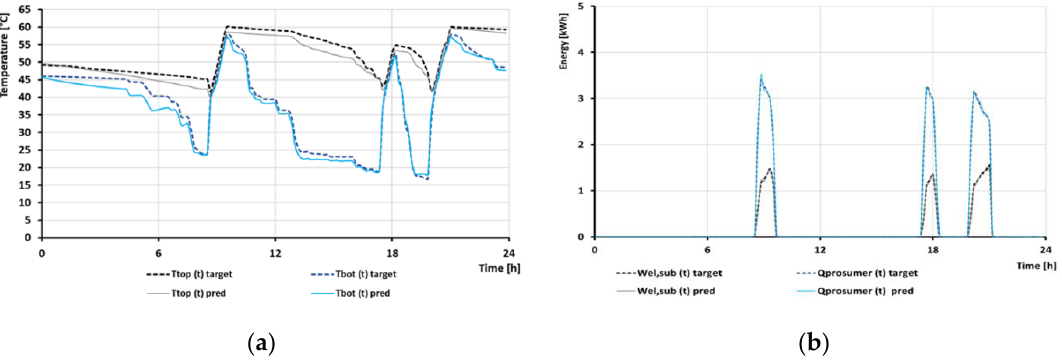
Figure 9. Target (dotted lines) vs. predicted (continue lines) outputs obtained during the closed-loop validation test of the DHW TES ( a ) and WSHP ( b ) ANN models. Table 1. Closed-loop results of the domestic hot water thermal energy storage (DHW TES) and water-